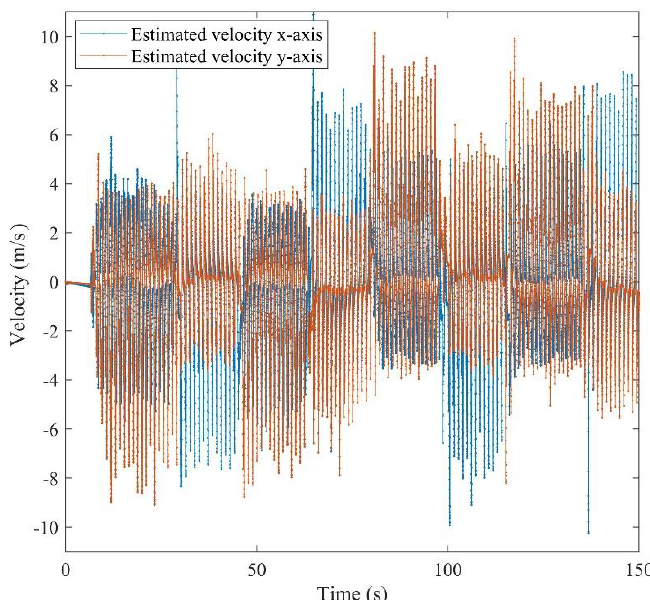
Figure 11. Estimated velocity of the pedestrian for x -axis and y -axis.